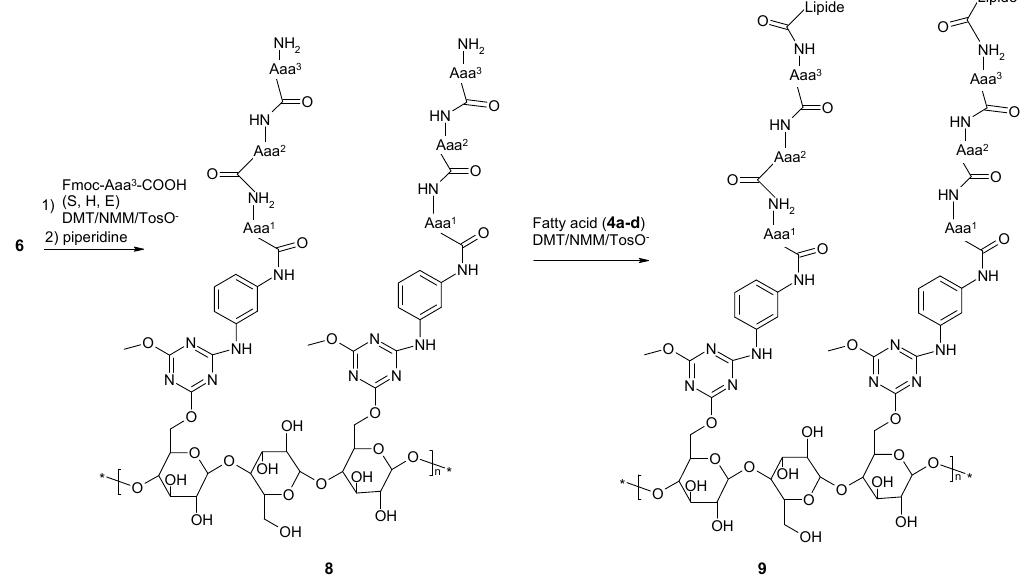
Figure 1 . Synthesis of N -lipidated amino-acids 5 , dipeptides 7 and tripeptides 9 immobilized on cellulose.